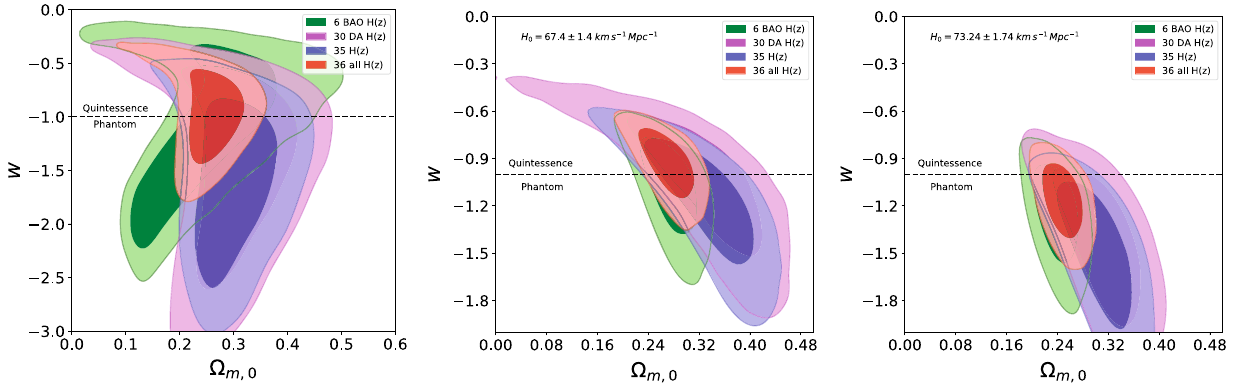
Fig. 2 Constraints on the parameters of wCDM cosmological model obtained with the expansion rate measurements H ( z ) . Upper plot was obtained using the reduced Chi-square function Eq. (9). Lower left one